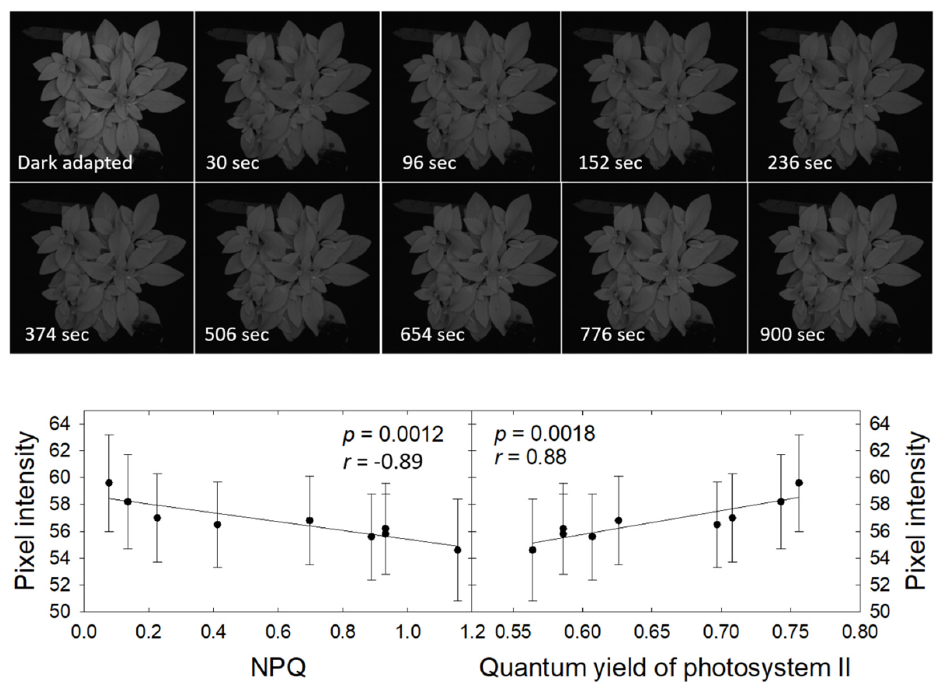
Figure 9. Chlorophyll fluorescence images of Petunia × hybrida following dark-adaptation and at different times following 15 min at a photosynthetic photon flux density of 550 µmol m − 2 s − 1 and subsequent return to darkness ( top ). The relationship between pixel intensity and measured NPQ ( bottom left ) and quantum yield of photosystem II ( bottom right ) (measured in the white square). The pixel intensity of the dark-adapted plant was 80.5 ± 5.0.